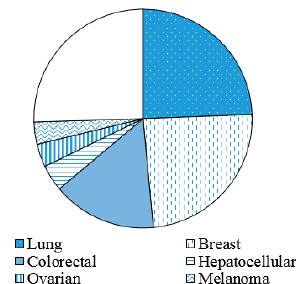
Figure 1. Proportion of the publication numbers reporting the use of circulating DNA in cancer types . This is a modification of figure 4 in Reference (21), web of science citation reports showing 5800 records for the cancer circulating DNA up to the end of 2018. The most studied cancer subtypes are lung cancer, breast cancer, and colorectal cancer, in that order.